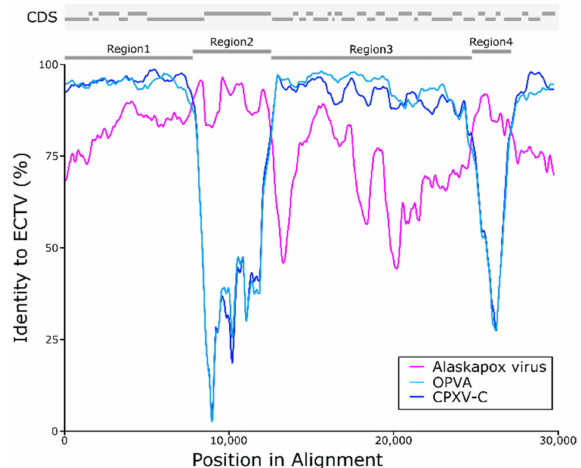
Figure 4. Potential recombination between Ectromelia virus (ECTV) and the Alaskapox virus (AKPV) isolate. Similarity plot displaying the sequence identity of AKPV, Orthopoxvirus Abatino (OPVA) and Cowpox virus (CPXV-C) to ECTV (Moscow strain) in the putative recombination region. Across most positions examined, OPVA and CPXV-C have higher similarity to ECTV than AKPV. However, the AKPV sequence has higher sequence identity than ECTV in two regions that can be seen as the pink AKPV line crossing the blue OPVA and CPXV lines. Above the graph, there is a schematic showing locations of annotated coding sequences (CDS), putative recombinant regions 2 and 4, and control regions 1 and 3.